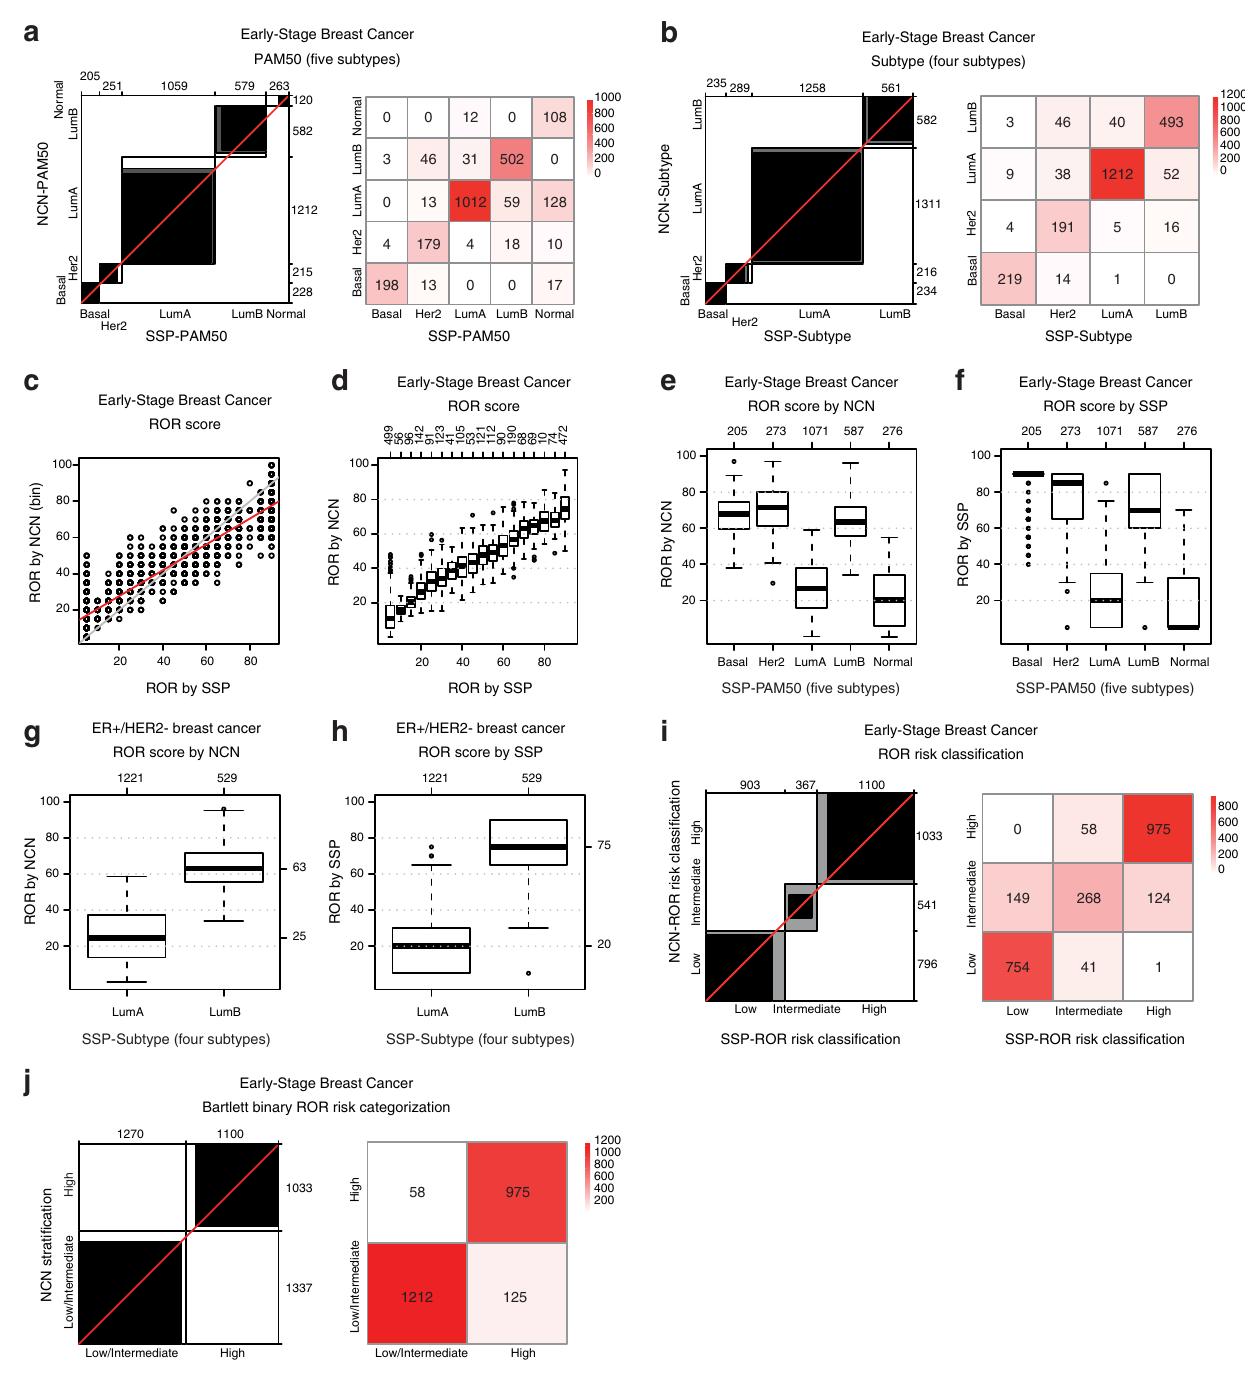
Fig. 2 Validation of SSP classi fi cations against NCN classi fi cations in the independent test set of early breast cancer. a Agreement chart and confusion matrix comparing SSP classi fi cations (x-axis/columns) with NCN classi fi cations (y-axis/rows) for PAM50 ( fi ve subtypes) and b Subtype (four subtypes). c Scatterplot of binned NCN-ROR values (y-axis) versus SSP-ROR (x-axis). d Boxplot of NCN-ROR values (y-axis) by SSP-ROR (x-axis). e Distributions of NCN-ROR values and f SSP-ROR values by SSP-PAM50 ( fi ve subtypes). g Distributions of NCN-ROR values or h SSP-ROR values, by SSP-Subtype (four subtypes) for ER + /HER2- breast cancer classi fi ed as Luminal A or Luminal B. i Agreement chart and confusion matrix comparing SSP classi fi cation (x-axis/columns) with NCN classi fi cation (y-axis/rows) for ROR risk classi fi cation and j